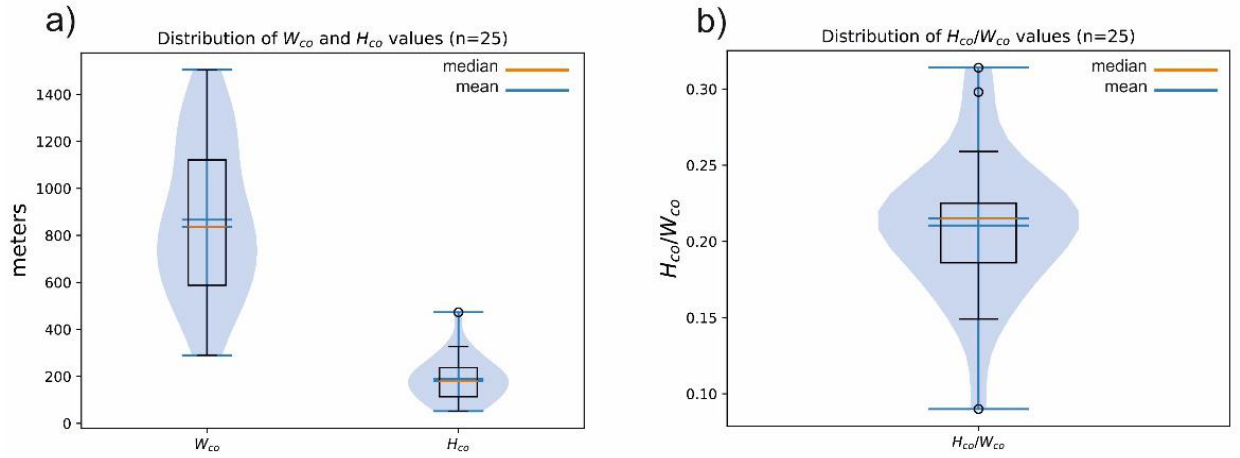
Figure 4. ( a ) Distribution of the basal diameter ( W co ) and the height of the cone ( H co ) and ( b ) distribution of the H co / W co values of the studied 25 volcanic cones of the Chaîne des Puys.